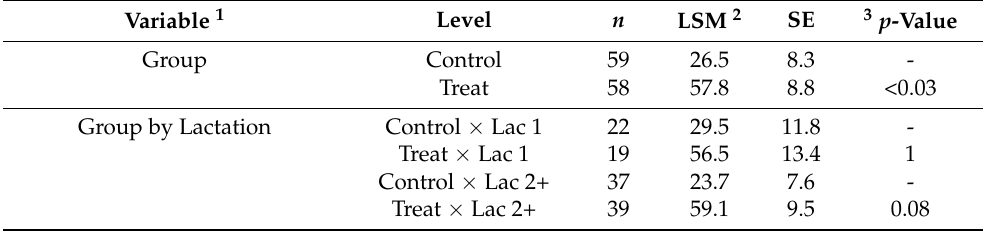
Table 4. Generalized mixed model (GLIMMIX) used to estimate the effect of administering GnRH at onset of estrus on probability of conception during the autumn only. Group and interactions with group are